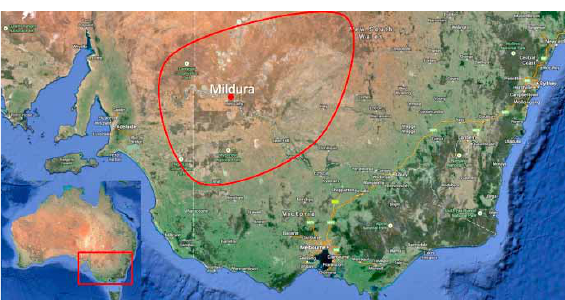
Fig. 1. Location of “Mildura Airport”, in Victoria, Australia, and the surrounding region which it serves (Imagery ©2015 TerraMetrica, Map data ©GBRMPA Google) Table 1. Land-use of Mildura Airport (Mildura Airport 2010: 4) Location Area (hectares)